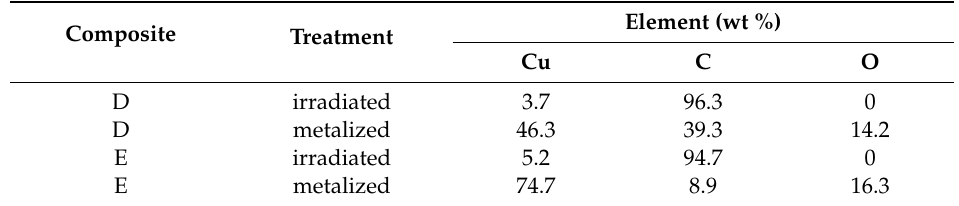
Table 5. EDX elemental analysis for composites E and D after laser irradiation (P = 8 W, v = 410 mm / s, f = 60 kHz) and metallization